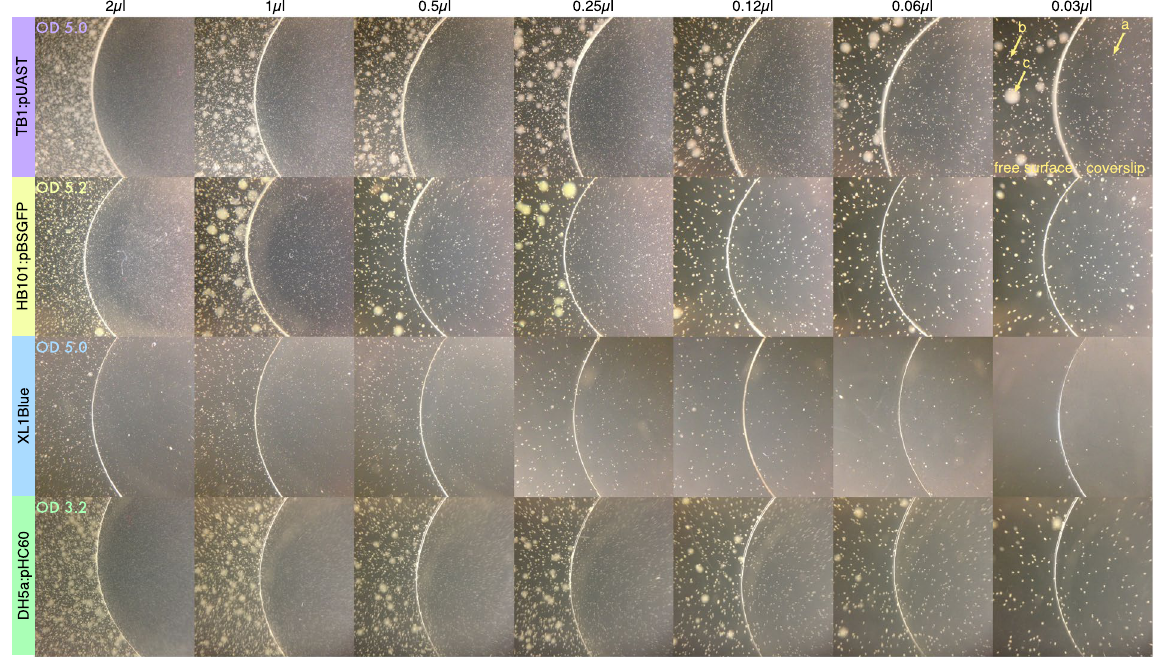
Figure 1. Influence of cell density on growth under coverslips. The optical density at 600 nm of the liquid cultures is indicated for each bacterial strain (first picture of each row). The soft-agar was inoculated with aliquots of 1/100 dilutions of the cultures and the equivalent amount of undiluted cultures is indicated at the top of each column. The top-right image reveals the layout of the assay: free surface and coverslip. Arrows